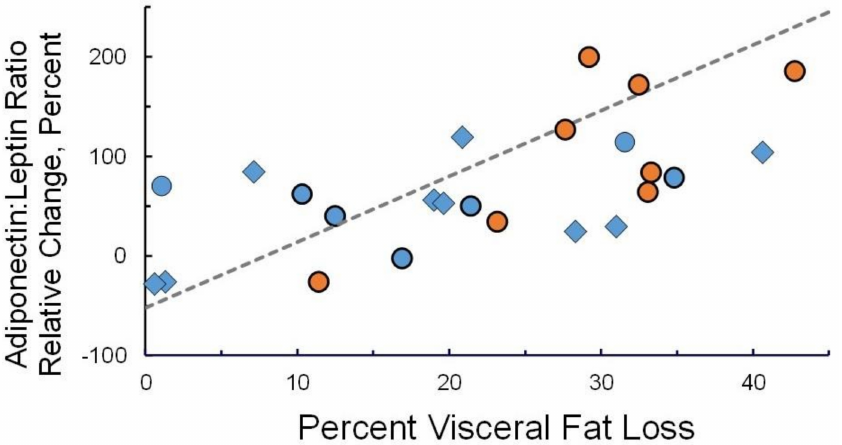
Figure 5. Change in serum adiponectin:leptin ratio at 12 and 24 weeks as a function of visceral fat lost, both relative to baseline values. Diamonds denote participants in cohort 1; circles denote participants in cohort 2 (blue = 12-week values; orange = 24-week values). Linear regression yields a slope of 6.6% change in adiponectin:leptin ratio per percent visceral fat loss ( p <